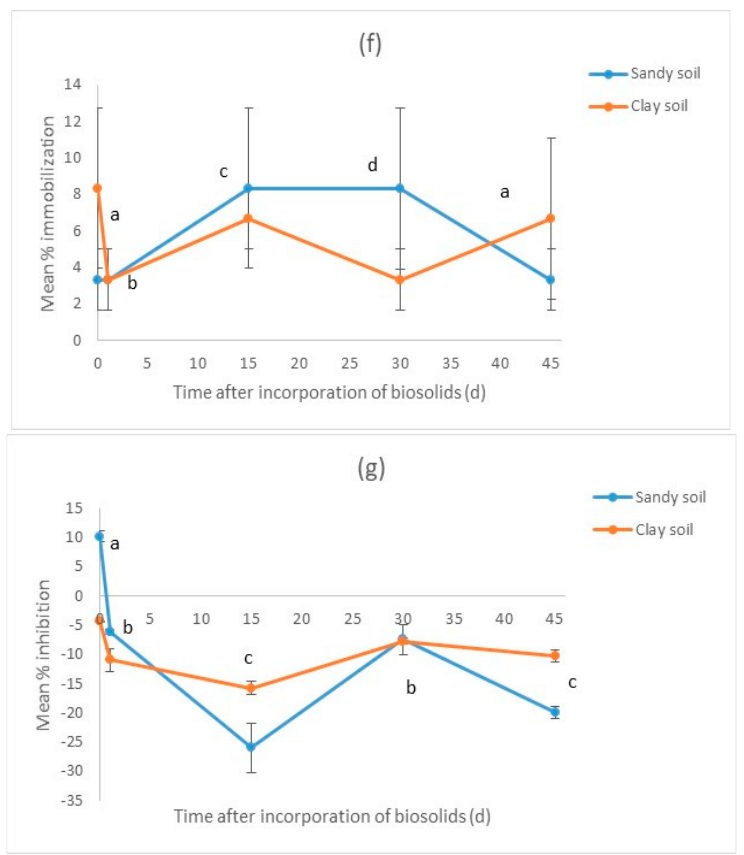
Figure 2. Time elapsed charts for electric conductivity ( a ), pH ( b ), TOC ( c ), nitrates ( d ), nitrites ( e ), % immobilization values for D. magna ( f ) and % inhibition values for V. fischeri ( g ) (the data for 15- and 30-min V. fischeri inhibition are not shown). A two-way repeated measures ANOVA was performed in order to test for the interaction of soil type and time duration. Different letters denote statistically significant differences between the tested groups (HSD post-hoc test).